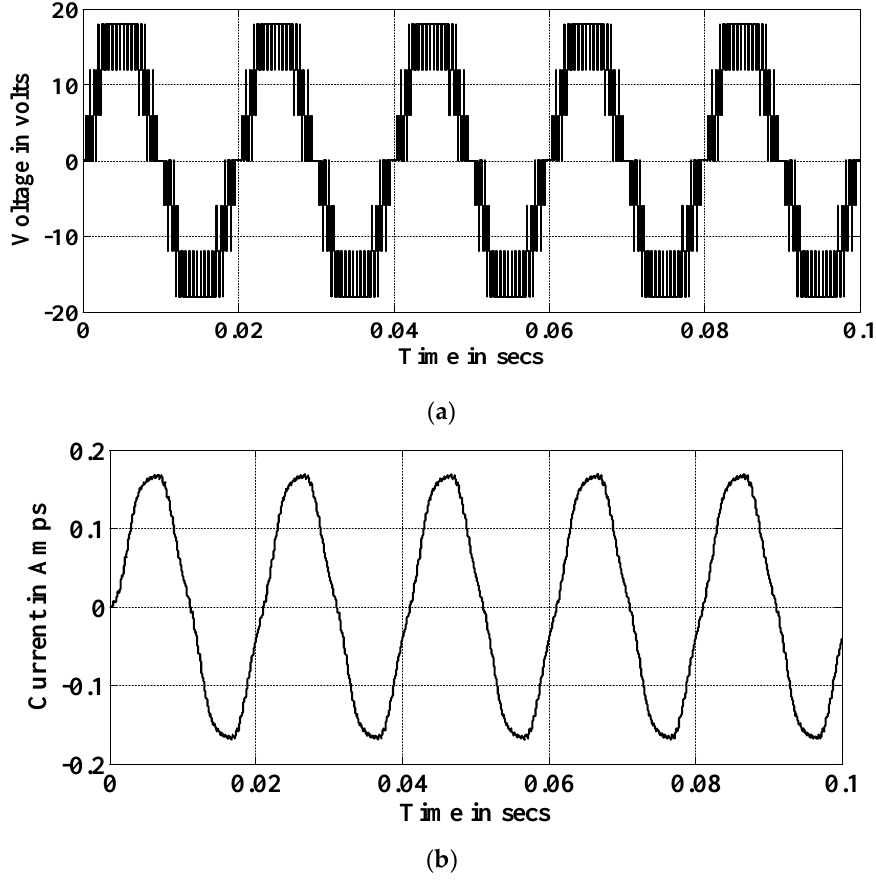
Figure 11. Output waveform for the COPWM strategy. ( a ) Voltage; ( b ) Current.